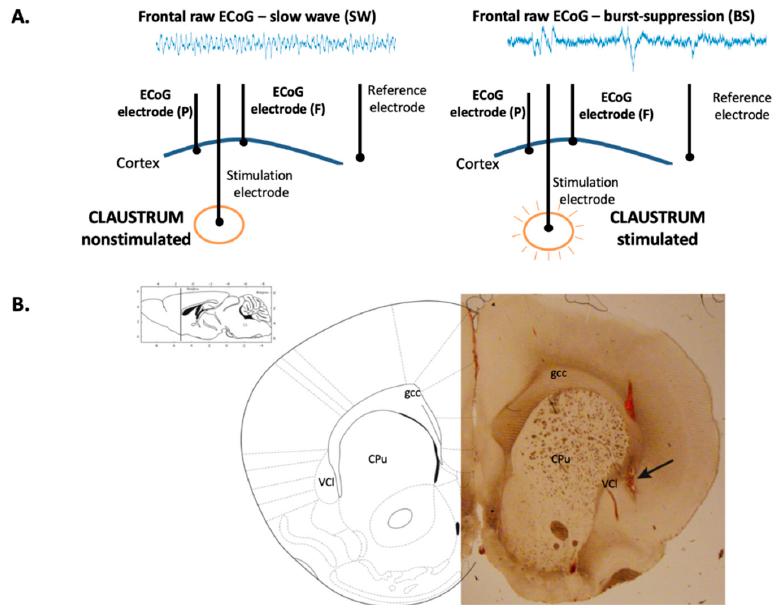
Figure 1. Electrodes placement and histological assessment. ( A ) Electrocorticogram (ECoG) features during nonstimulation and stimulation of claustrum. The placement of the electrodes for stimulation and recording in the frontal (F) and parietal (P) cortex are shown. ( B ) Histological image of a coronal rat brain slice presenting the stimulation electrode trace in claustrum (black arrow). Ventral claustrum (VCl), caudate putamen (CPu), genu of corp. call (gcc). (adapted from Paxinos and Watson (2009). The rat brain in stereotaxic coordinates. Amsterdam: Elsevier/Academic).